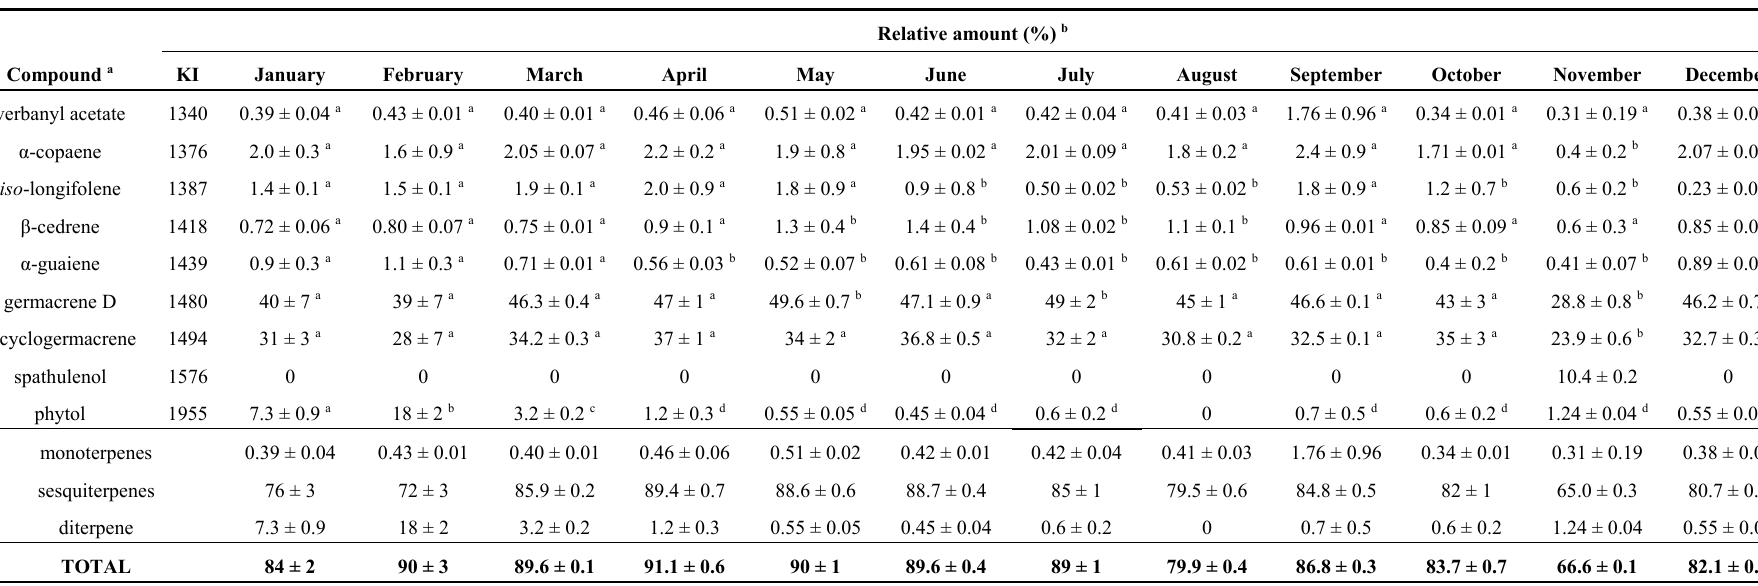
Table 1. Seasonal variation of the chemical composition of essential oils obtained from the leaves of Porcelia macrocarpa (monthly collection from January to December